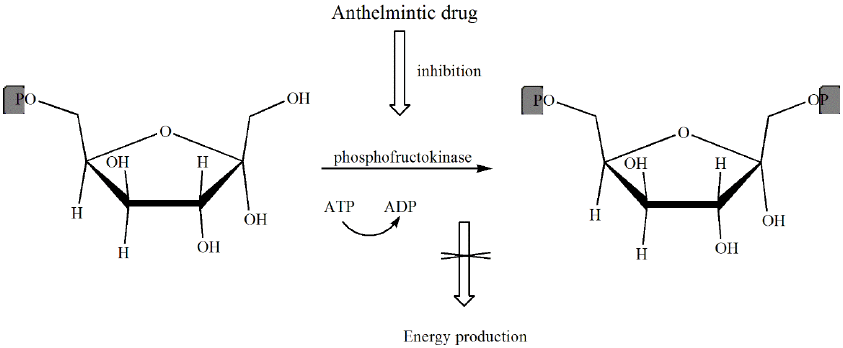
Scheme 4. The mechanism of action of anthelmintic drugs.